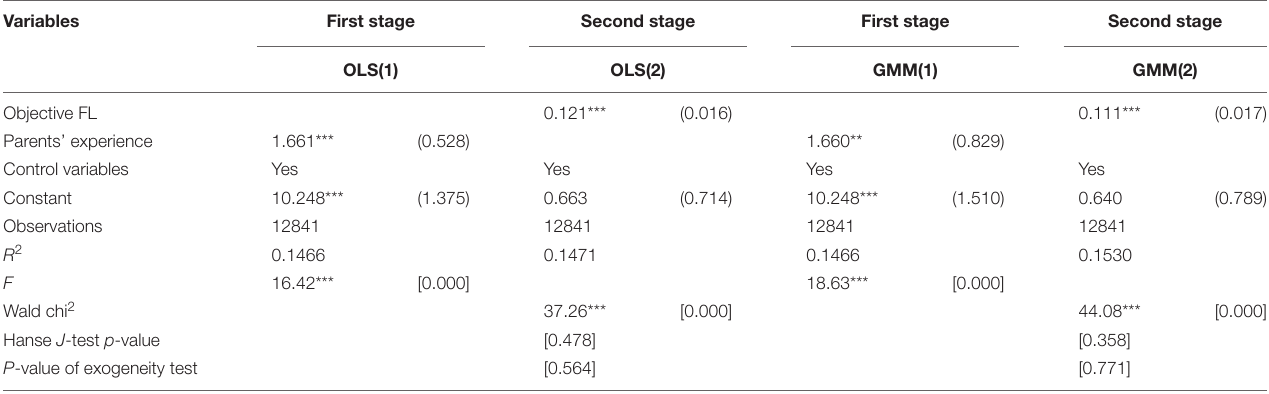
TABLE 11 | The comparison of 2sls and GMM